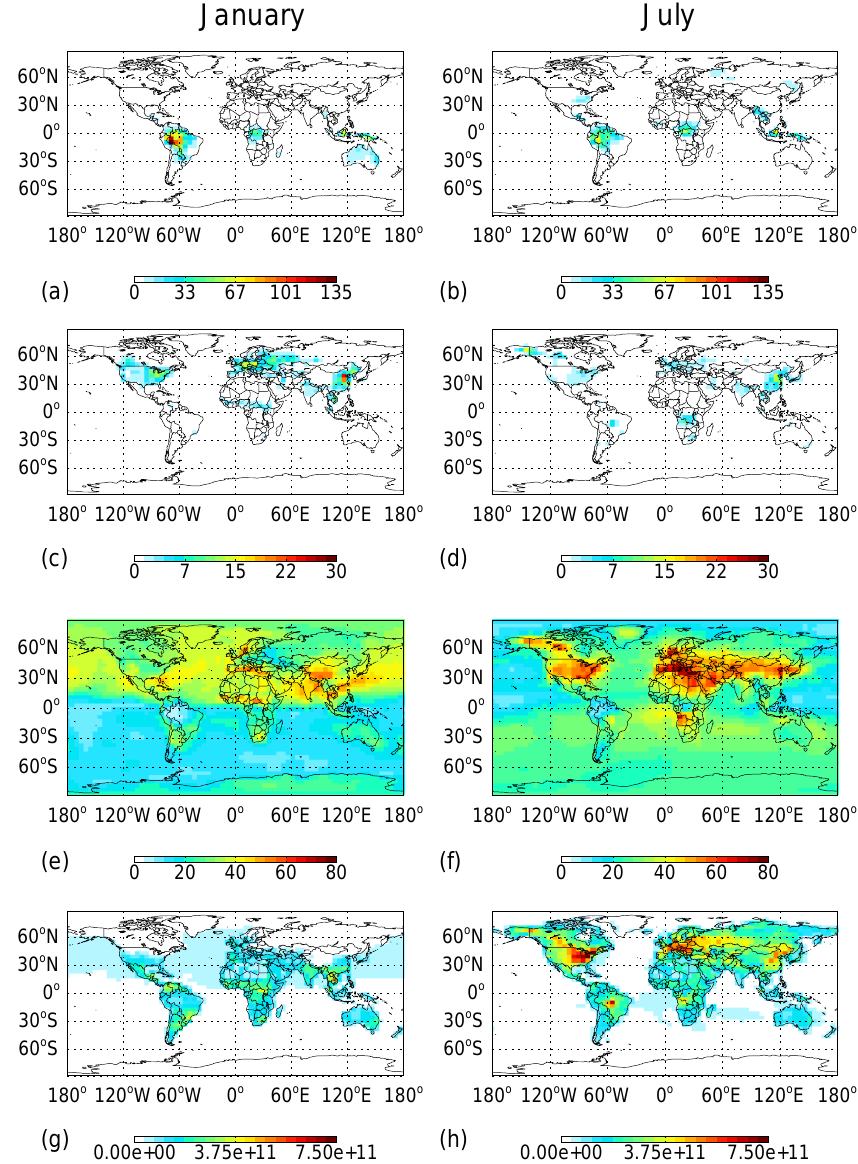
Fig. 5. Surface concentrations of isoprene in ppb, (a) and (b) ; NO x in ppb (c) and (d) ; O x in ppb (e) and (f) and O 3 surface flux in moleculescm − 2 s − 1 (g) and (h) for ZLUC calculation. Plots for January and July and shown in the left and right panels,